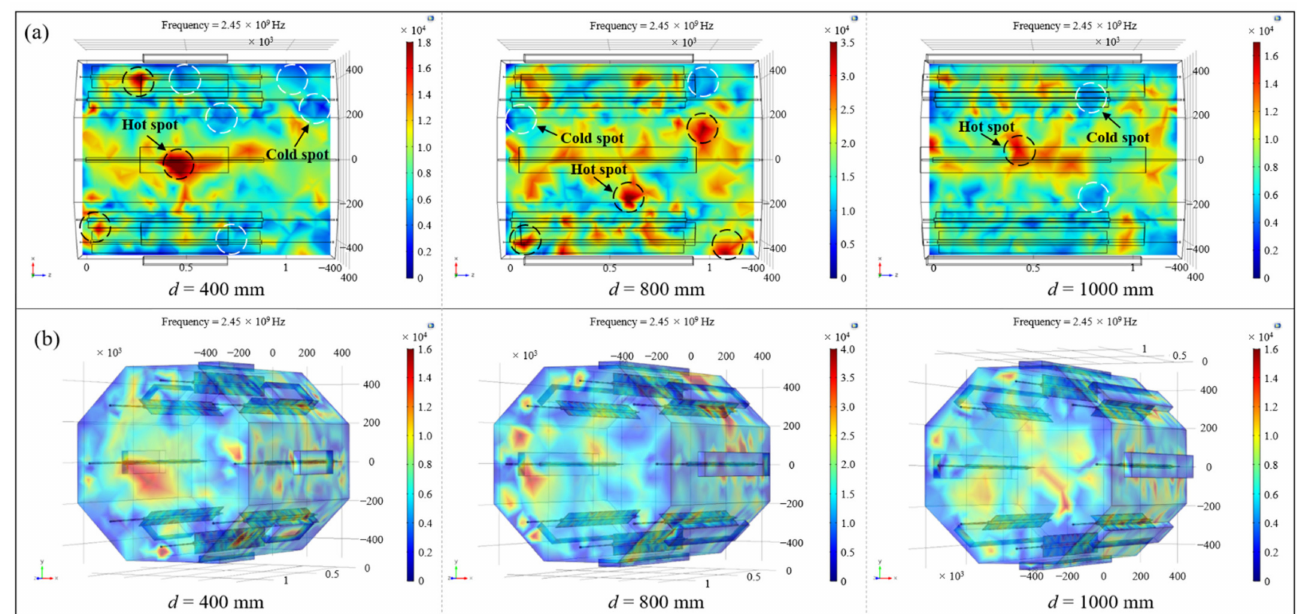
Figure 5. ( a ) The electric field nephograms of the platform; ( b ) the spatial electric field distribution in the cavity.